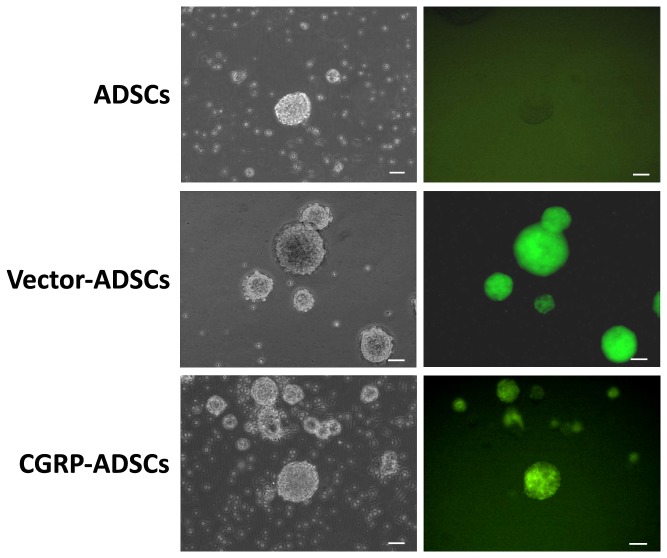
CGRP overexpression promoted neurosphere formation.When ADSCs approached densities of approximately 80%, all groups were induced toward the neurogenic lineage through neurosphere formation. Apparently, the size and quantity of neurospheres were increased CGRP-ADSCs compared with the other groups. Scale bars = 100 µm.